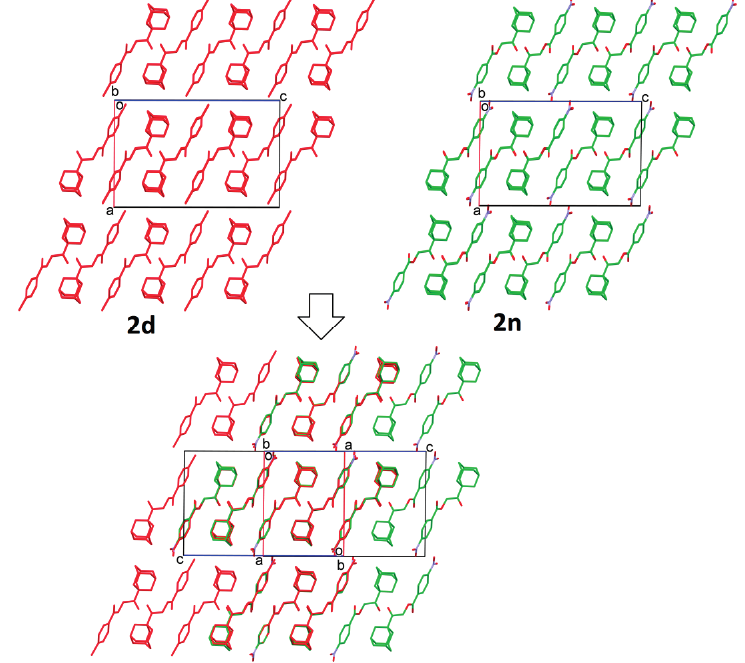
Figure 6. Crystal packing comparison of Compounds 2d and 2n .